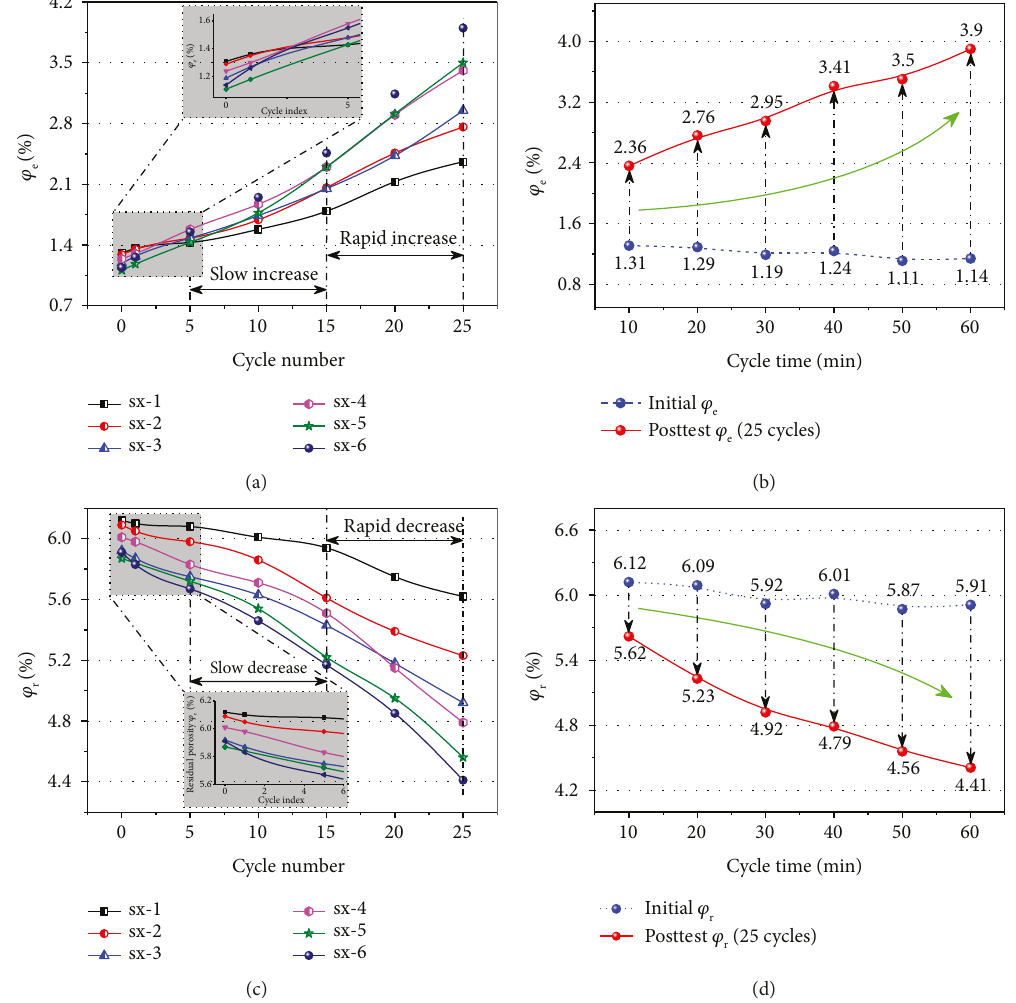
Figure 9: Variations in the φ